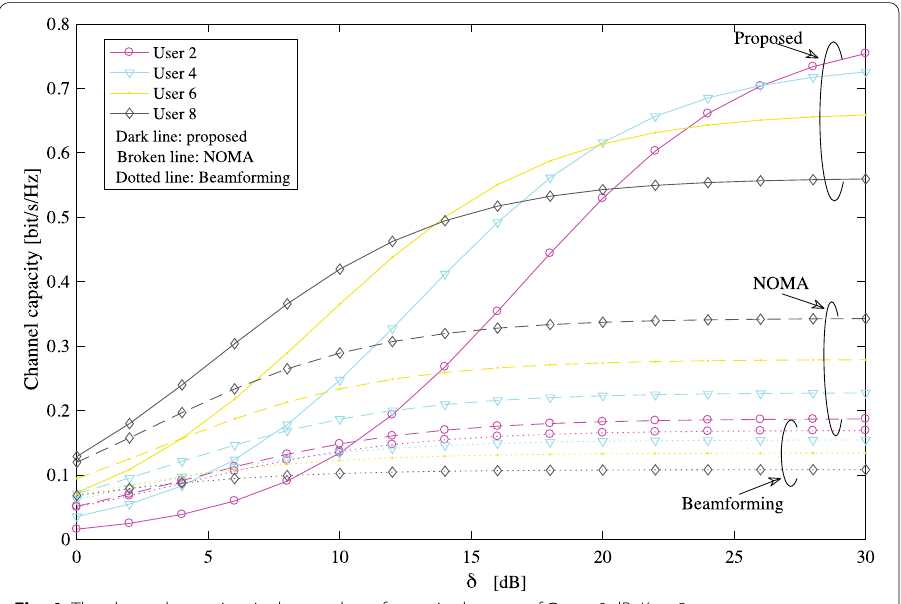
Fig. 4 The channel capacity via the number of users in the case of (cid:31) K = 0dB , K =